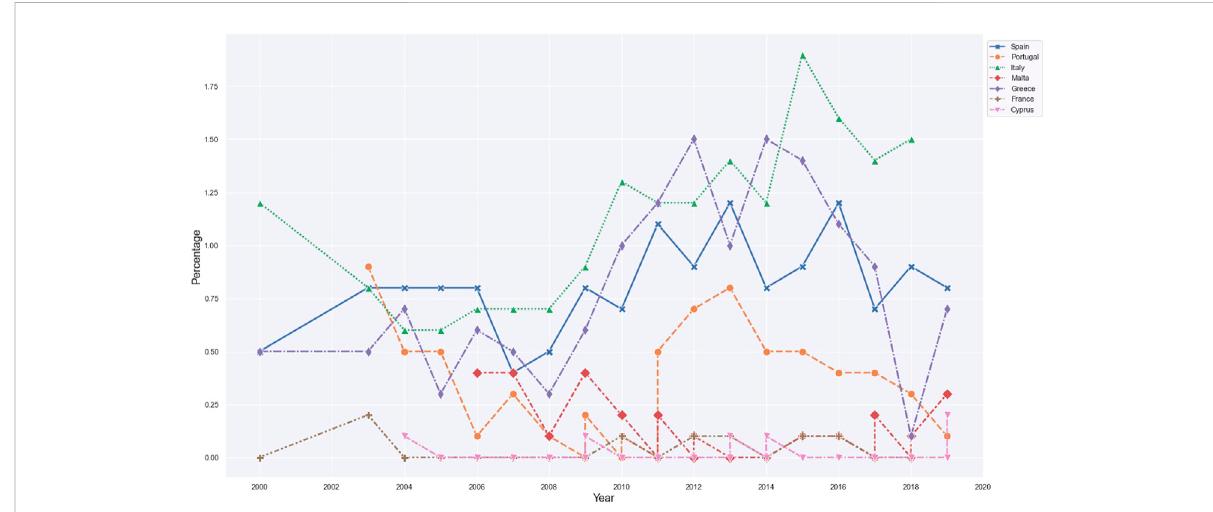
FIGURE 8 Monitoring of an UN SDG indicator across countries in the Mediterranean.